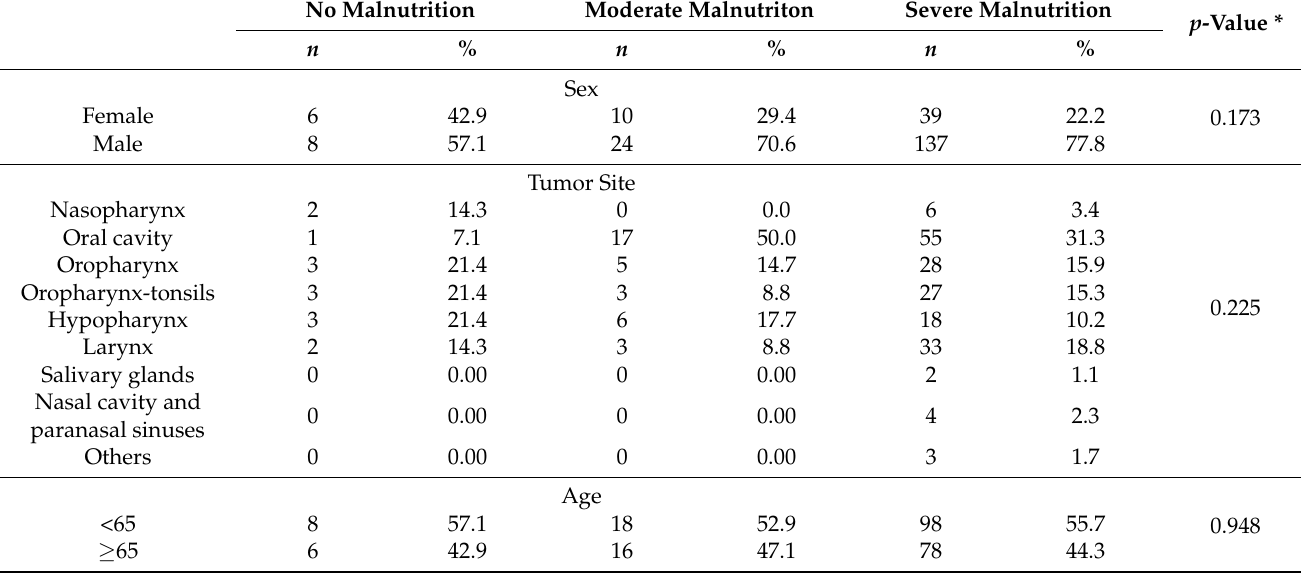
Table 4. Prevalence of malnutrition based on GLIM criteria divided by sex, tumor site, and age. No